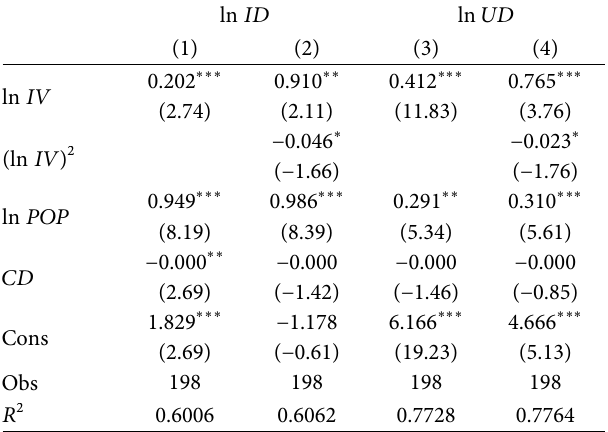
Figure 6: Robustness test. Table 6: Inspection of the Kuznets curve of water